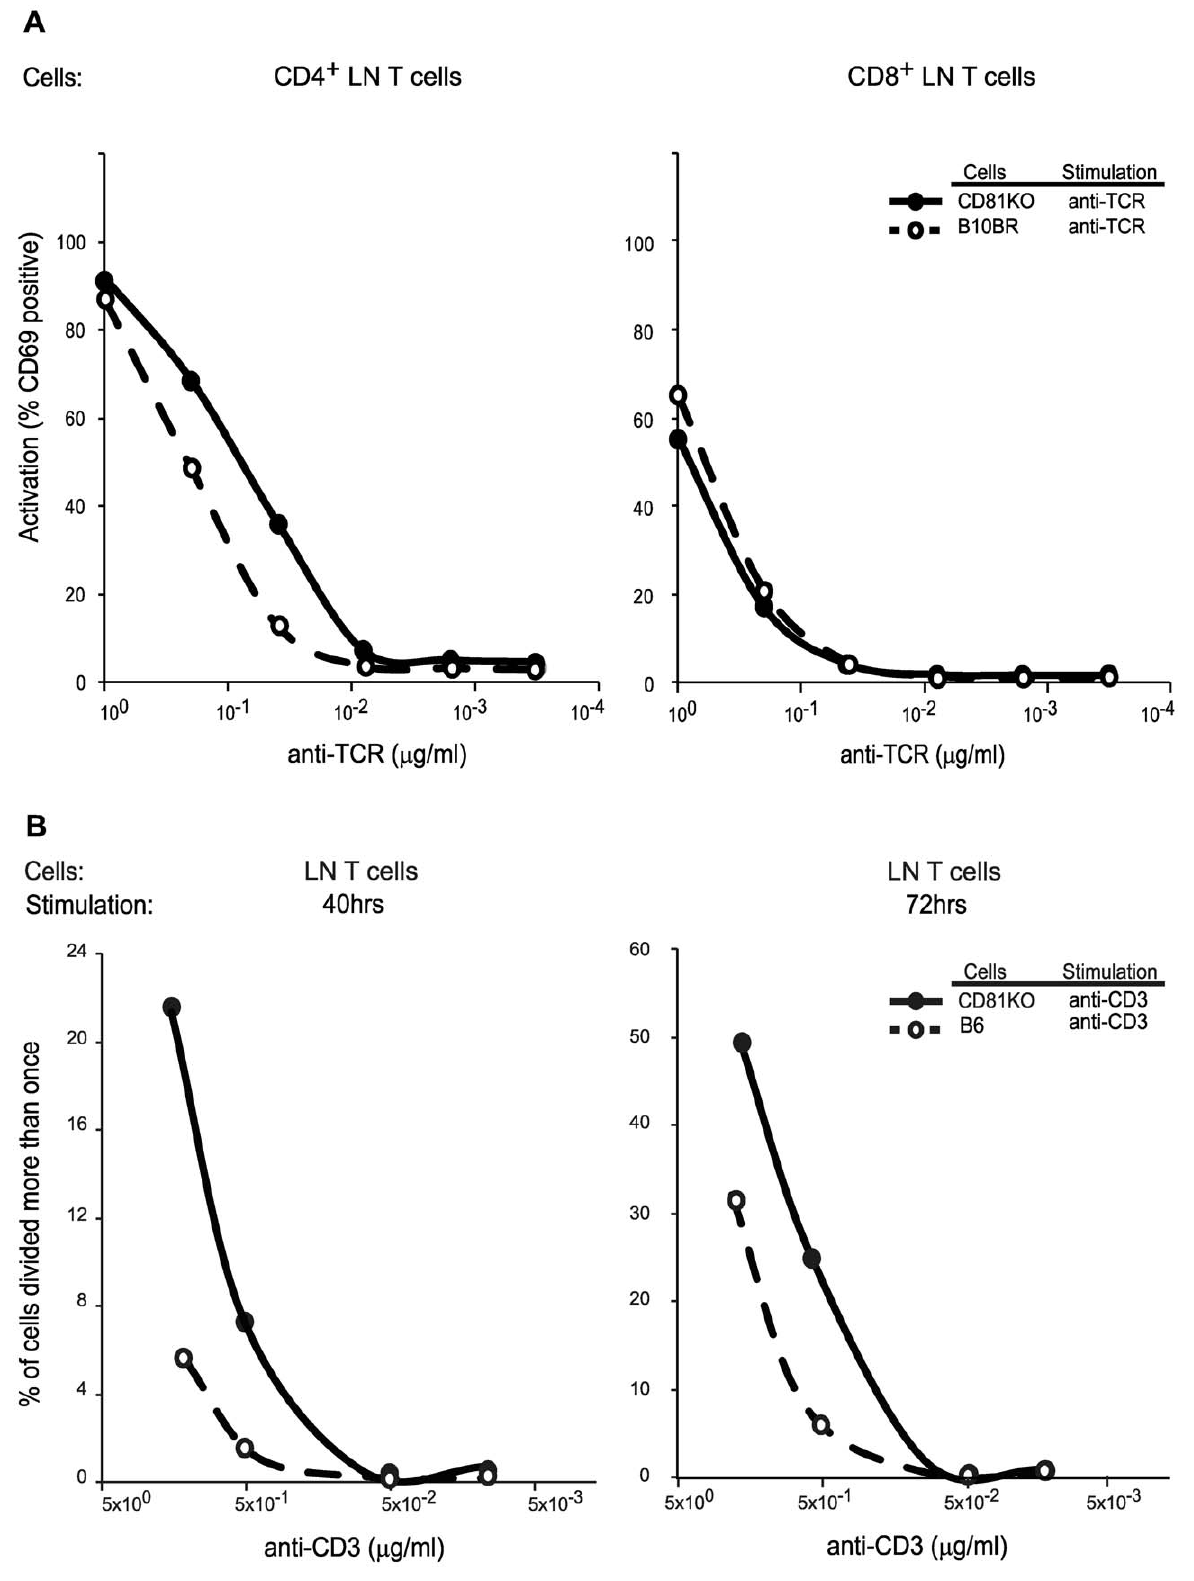
Figure 5. CD81 deficiency increases in vitro TCR signaling intensity in CD4 + lymph node T cells. ( a ) Deficiency of CD81 results in more cells that upregulate CD69 upon TCR signaling. Purified LN T cells from B10 or CD81 2 / 2 mice were assessed for anti-TCR + anti-CD4 induced up- regulation of CD69 expression. Left panel: After overnight stimulation with plate bound anti-TCR antibodies, electronically gated CD81 2 / 2 CD4 LN T cells (filled circles) upregulated dramatically more CD69 compared to WT B10 CD4 LN T cells (open circles). Right panel: Stimulation with anti-TCR did